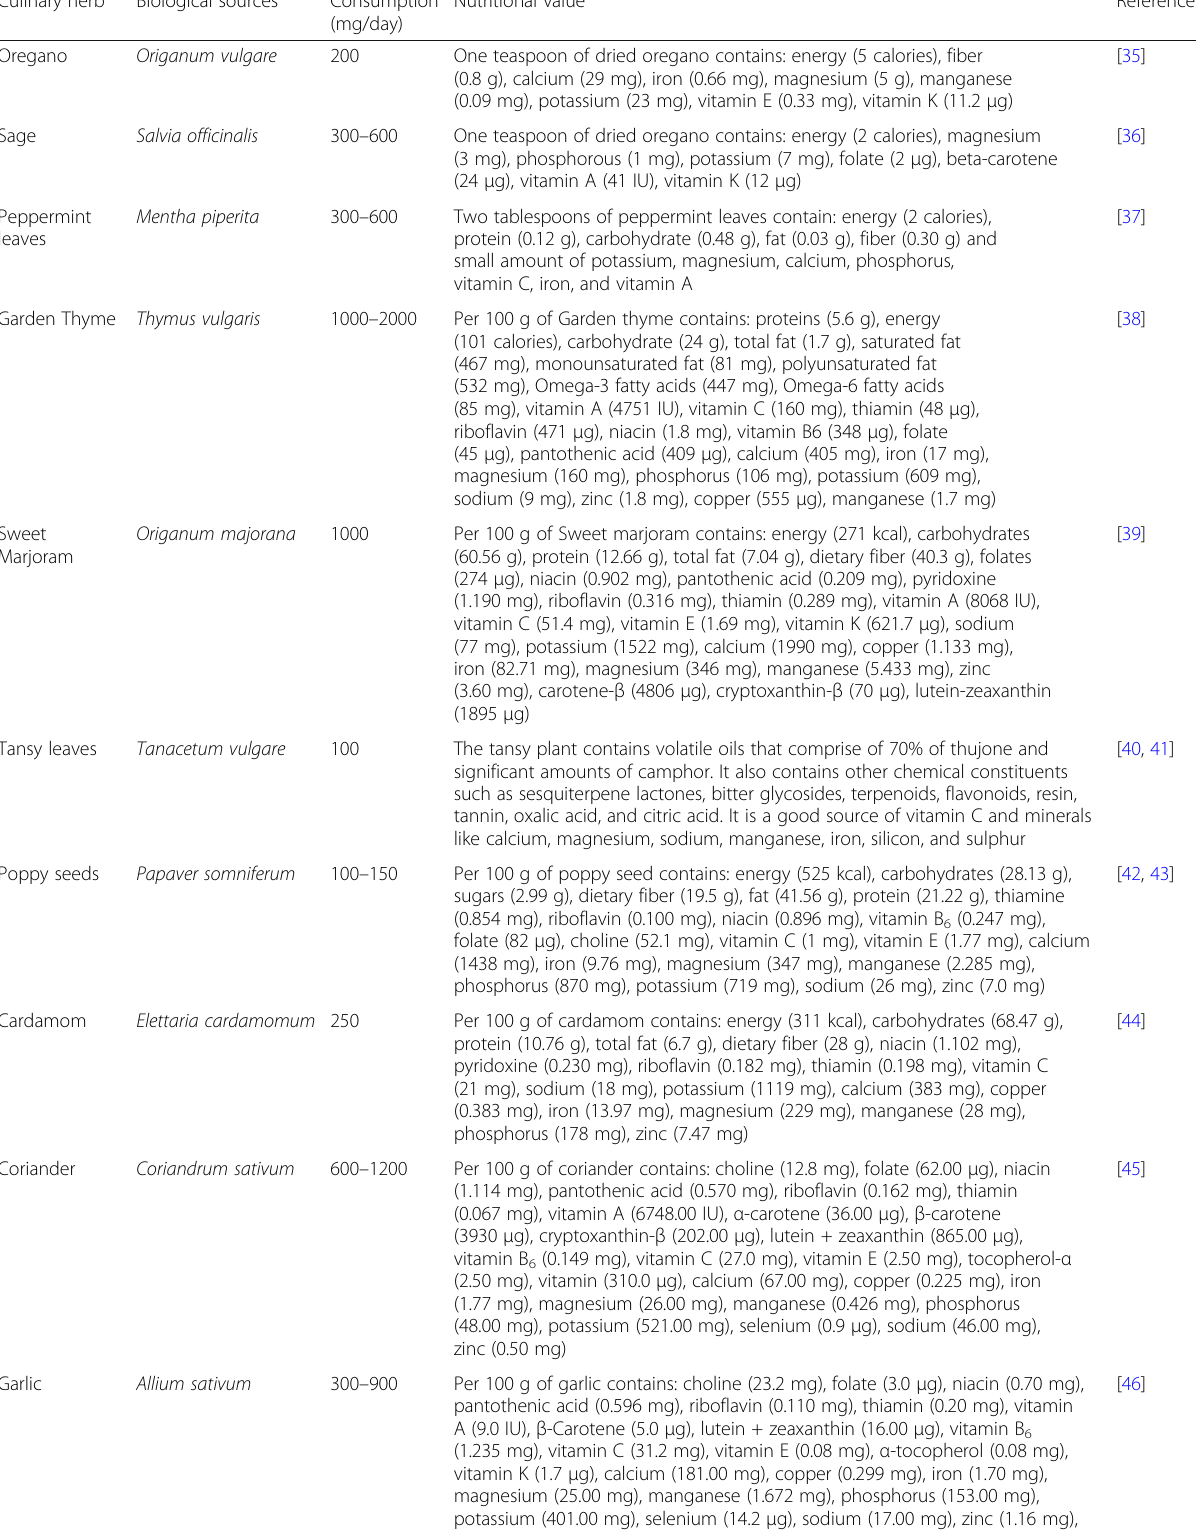
Table 2 Culinary herbs and spices in daily